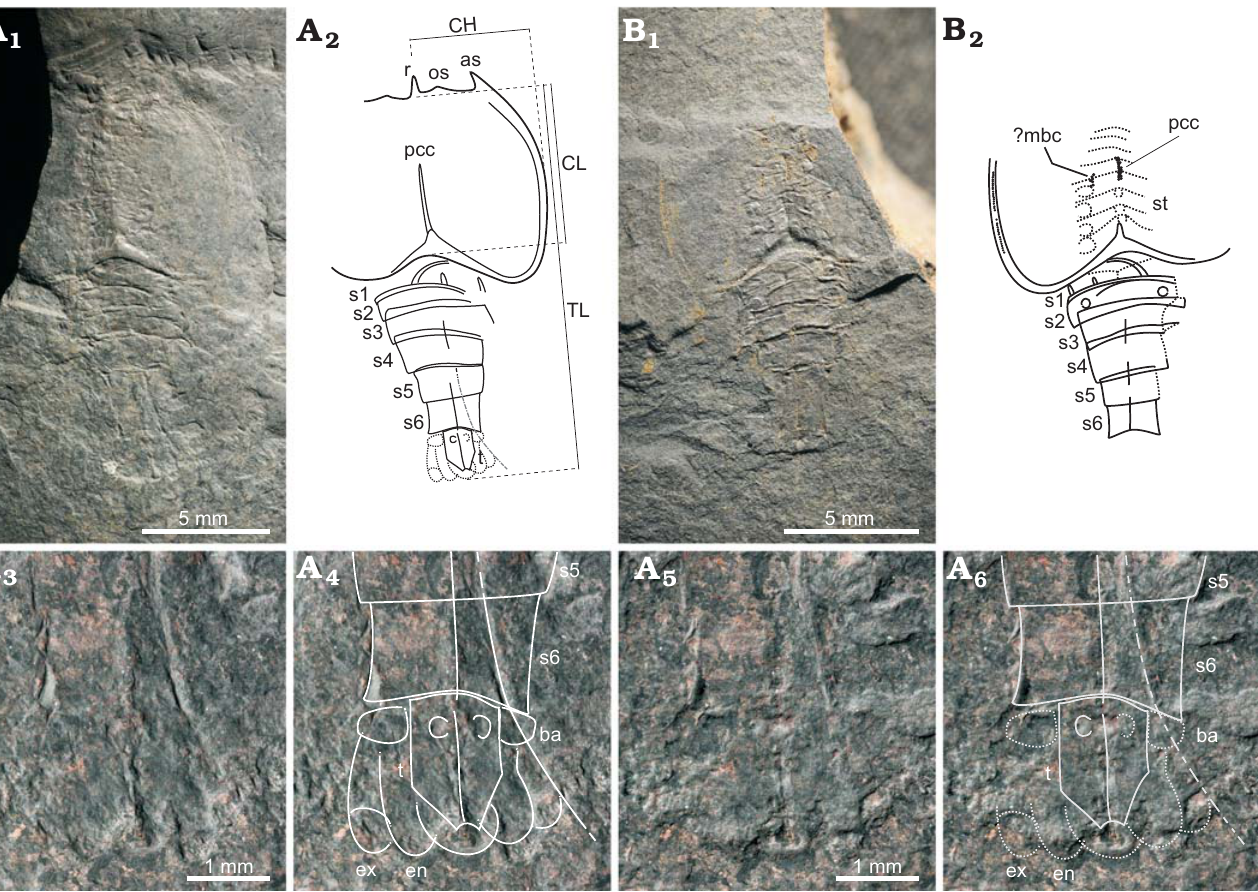
Fig. 2. Tealliocaridid crustacean Laevitealliocaris xiaheyanensis gen. et sp. nov. from the Xiaheyan locality (Ningxia, China), Tupo Formation (Late Car- boniferous). Holotype (CNU-NXI-540c–p, part and counterpart), articulated specimen. A . CNU-NXI-540c; general view (A , A ). B . CNU-NXI-540p. Photographs (A telson (A 5 6 and OB)